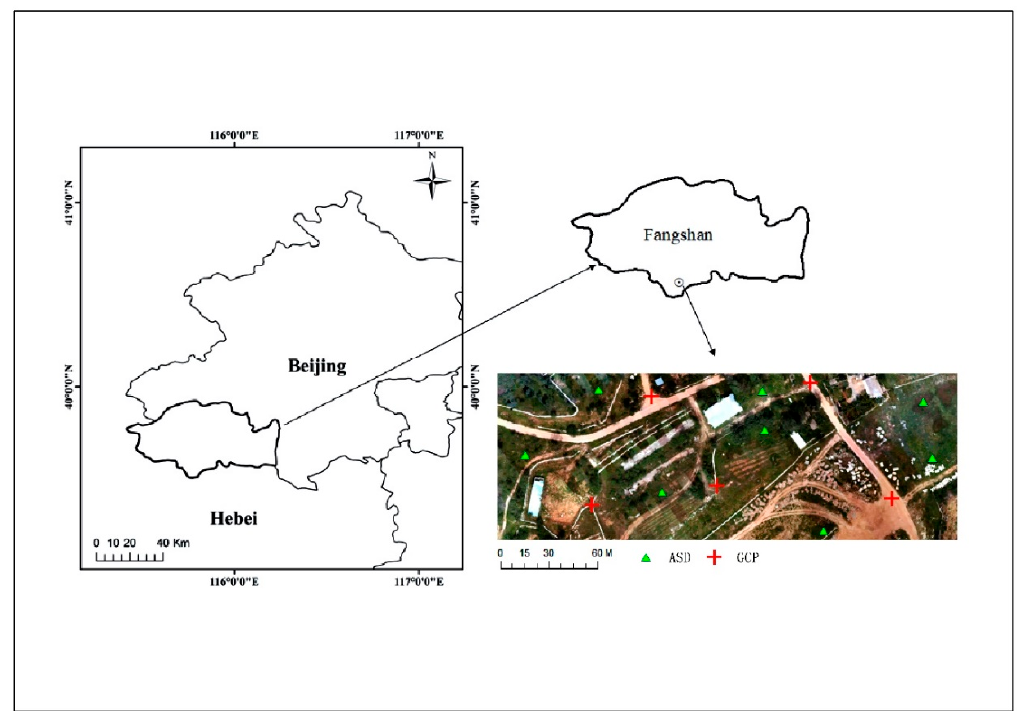
Figure 1. Location of study area.